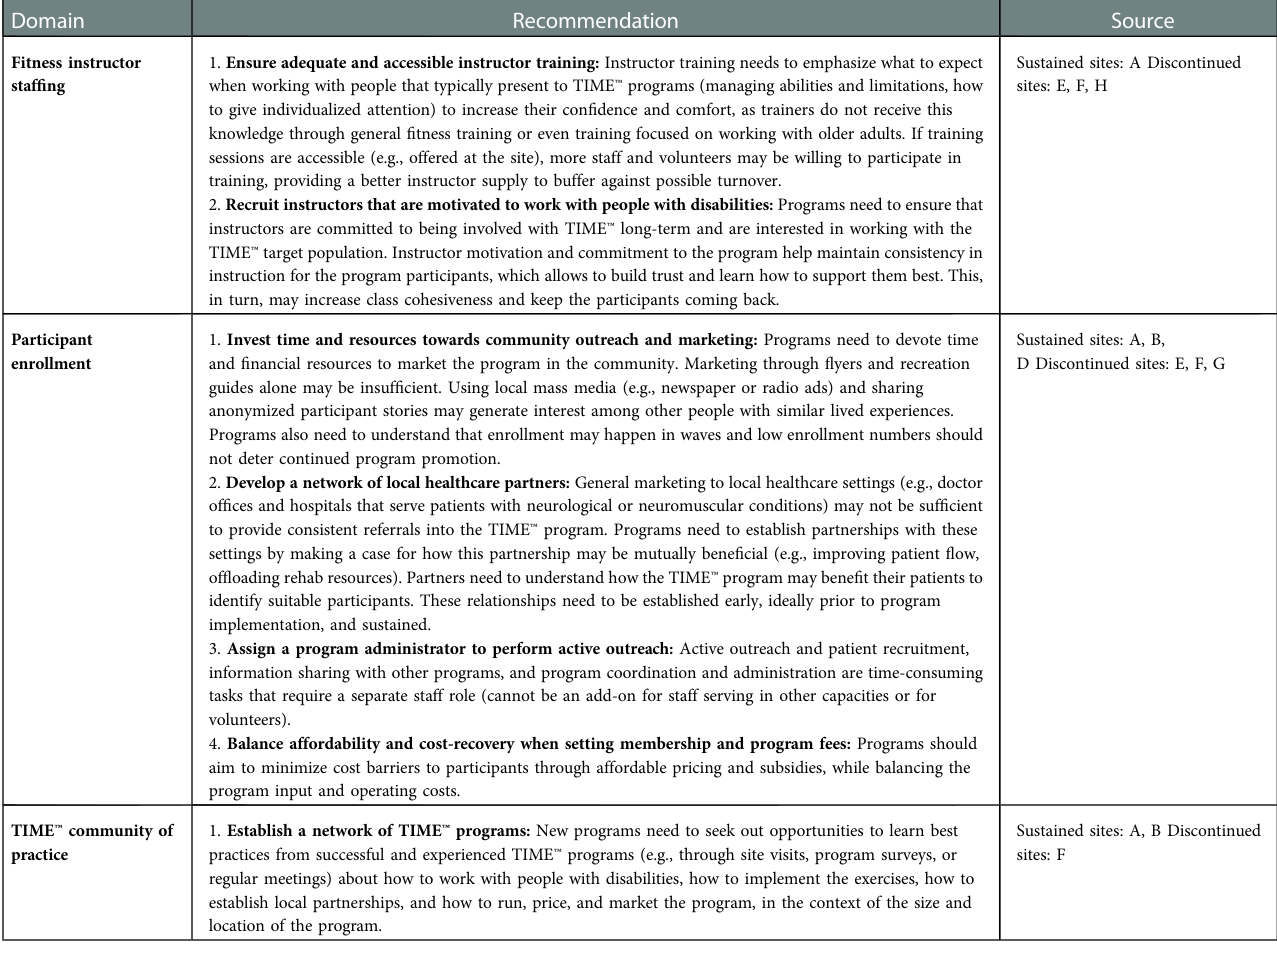
TABLE 6 Recommendations to promote program sustainability from participating sites.